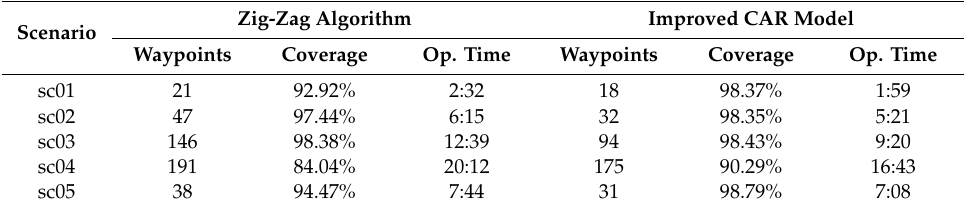
Table 5. Comparison of the improved CAR model with the zig-zag algorithm.